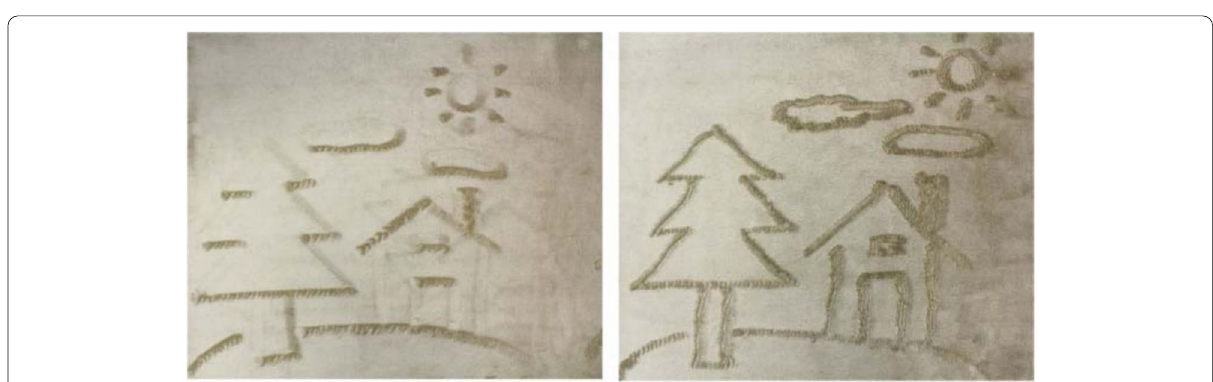
Fig. 17 Patterns drawn on the blanket with fingers are blurrier than that drawn with the device